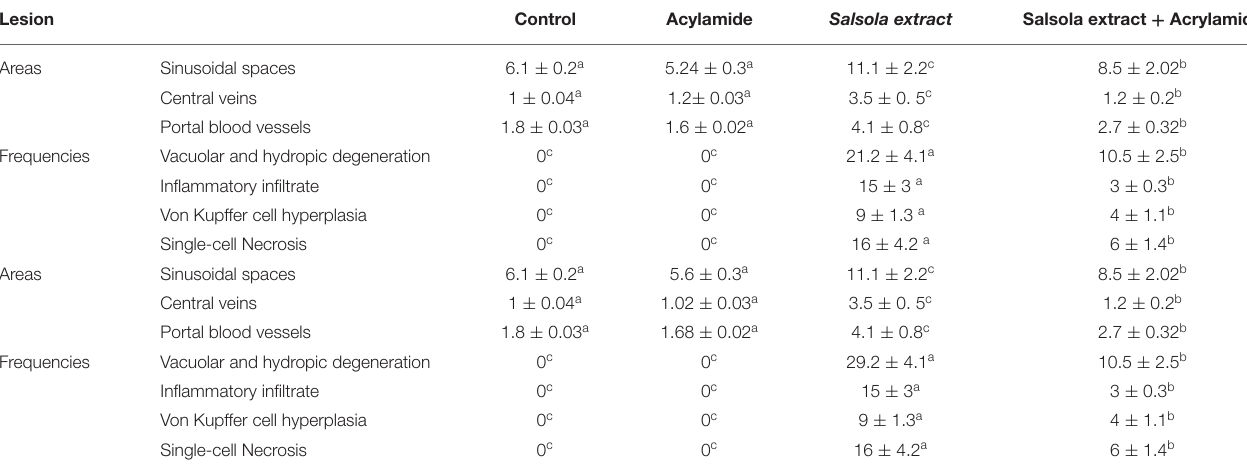
Values are mean ± SE for 4 slides/group. Means within the same row (in each parameter) carrying different superscripts are significantly different at p <